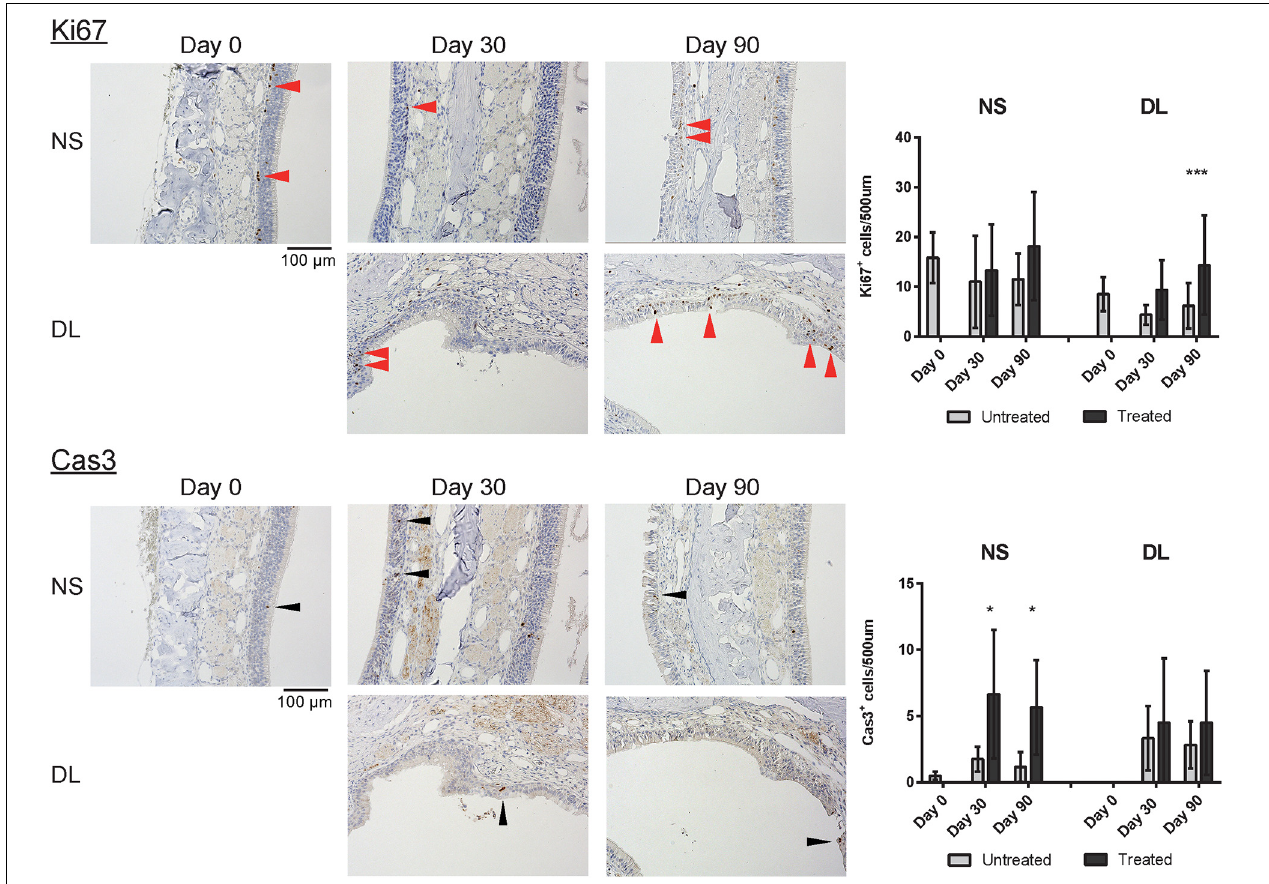
FIGURE 6 | Representative images of sections of the nasal mucosa stained with antibodies against Ki67 and Cas3 (magnification, 200 × ). Ki67 + dividing cells (red arrowheads) and Cas3 + apoptotic cells (black arrowheads) were rarely present in the nasal epithelium on day 30, whereas several Ki67 + cells were observed in the DL area on day 90. Asterisks indicate a significant difference between the treated and untreated groups. * P < 0.05; *** P < 0.001 ( n = 6, two-way analysis of